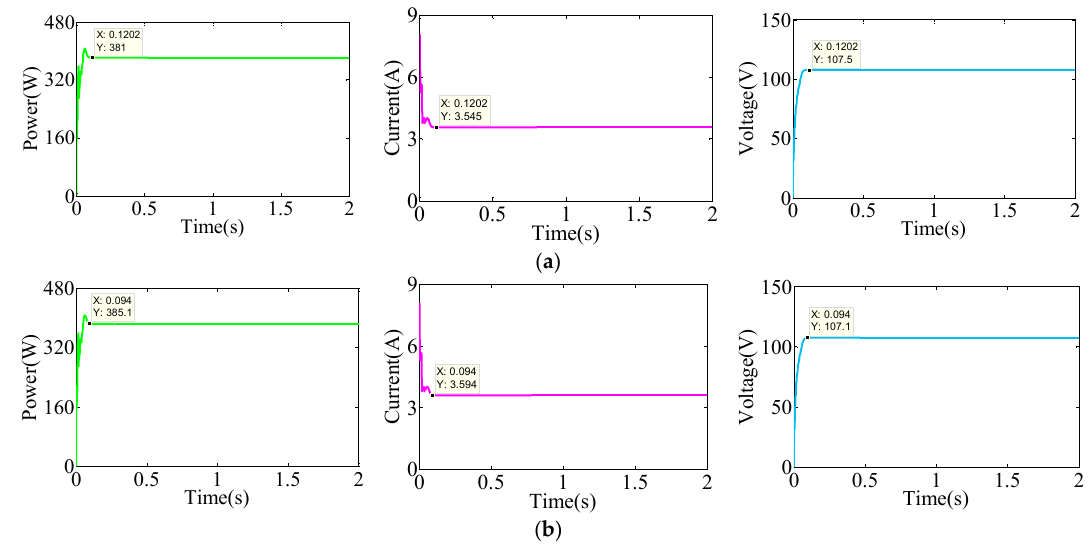
Figure 16. Power, current and voltage tracking curves of FPA and MFPA for partial shading conditions ( a ) FPA; ( b ) MFPA.